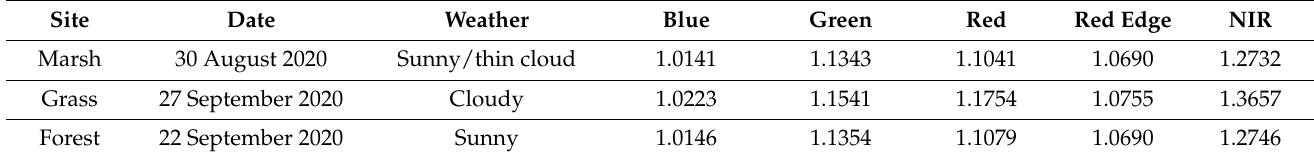
Table 5. Correction factors of the five RedEdge-M bands in three missions (marsh, grass, forest).